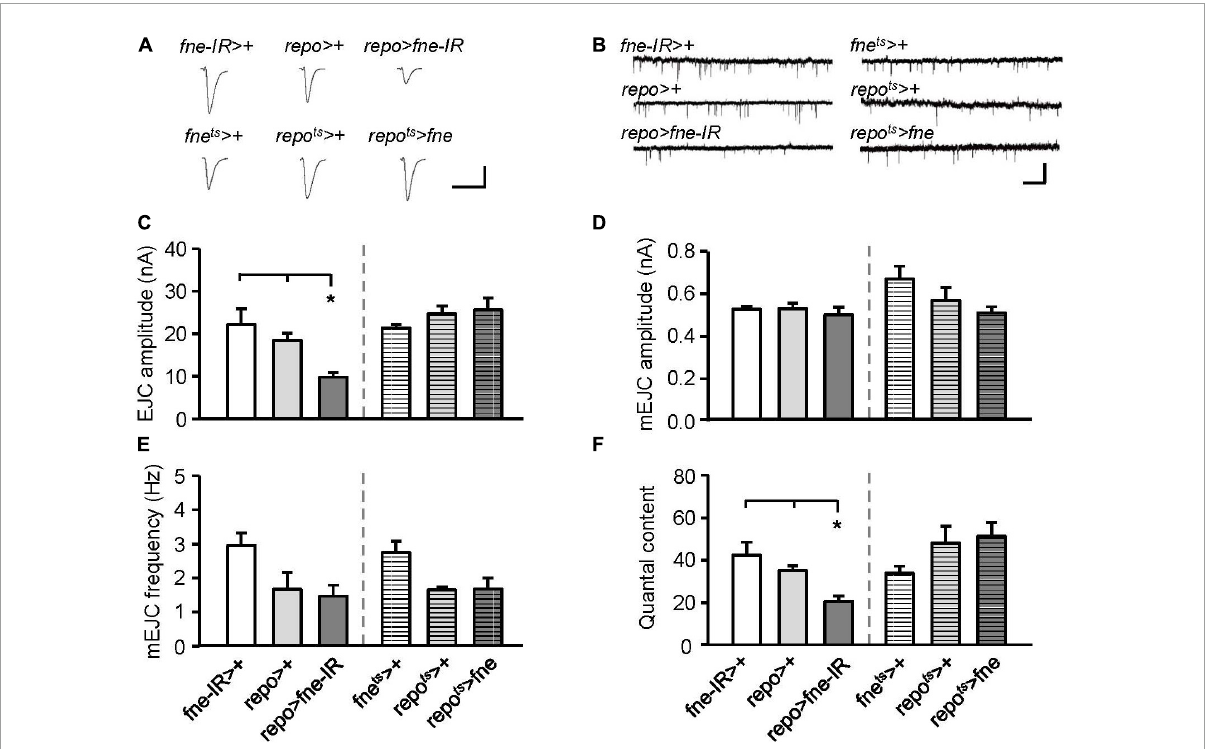
FIGURE7 Change of fne expression in glia altered the synaptic transmission in the larval NMJ. (A) Representative traces of EJC while the glia expressing fne and fne-IR . Calibration: 10 nA, 50 ms. (B) Representative traces of mEJC in the indicated genotypes. Calibration: 1 nA, 1 s. Quantification of (C) EJC amplitude, (D) mEJC amplitude, (E) mEJC frequency, and (F) quantal content. Bars with horizontal lines represented the flies that were reared at 18 ◦ C and shifted to 29 ◦ C for 1 day to induce fne expression. Error bars represent SEM. * p < 0.05, n = 8 for each